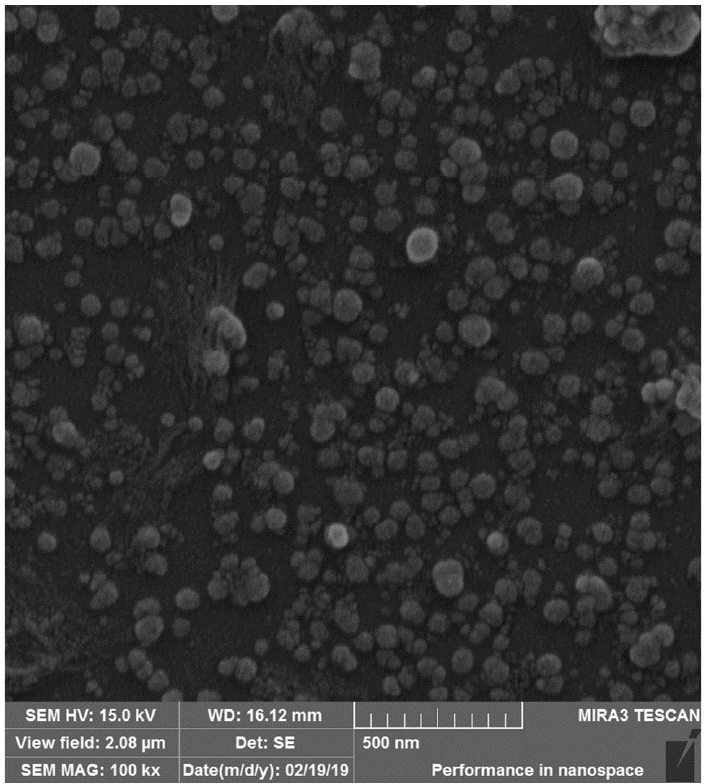
Fig. 2. Morphology of VCZ- loaded nano-liposome determined by SEM